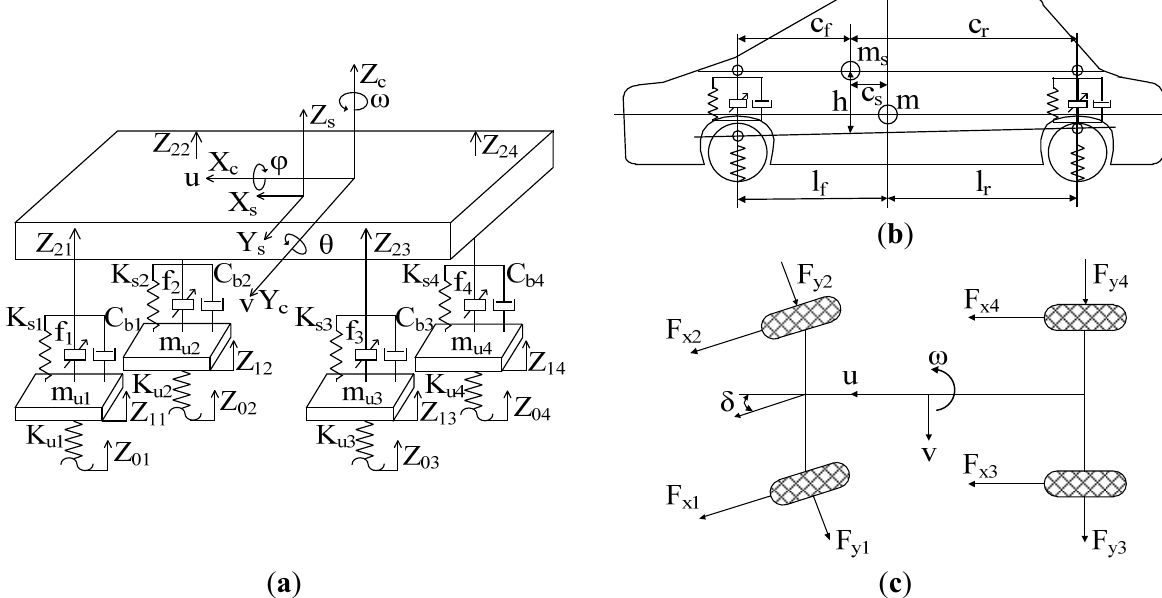
Figure 1. Vehicle dynamics model: ( a ) Vehicle reference coordinate system; ( b ) Vehicle side view; ( c ) Vehicle top